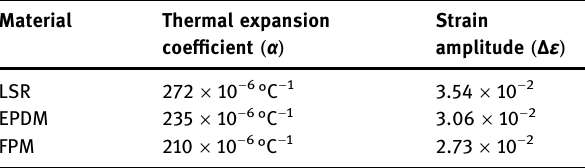
Table 1: Rubber material parameters